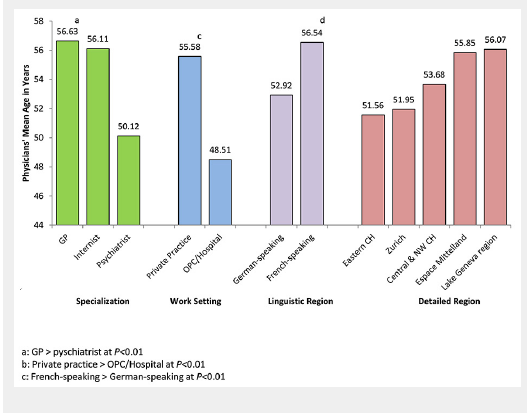
Figure 3 The age profile of the interviewed physicians by specialisation, work setting, linguistic region and detailed regional distribution. GP = general practitioner; OPC = outpatient clinic